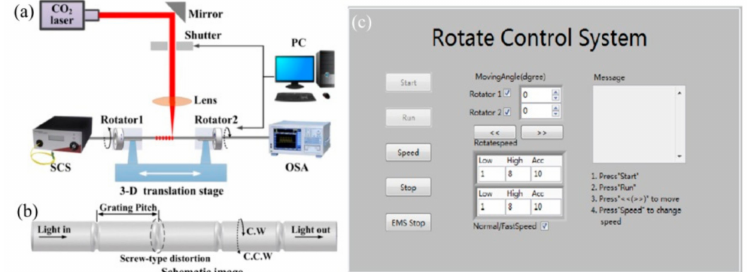
Figure 5. ( a ) Schematic diagram for fabricating pre-twisted LPFG by use of CO2 laser; ( b ) microscope image of a right-helix pre-twisted LPFG with permanent screw-type deformation; ( c ) operation interface of the pre-twisted LPFG fabrication system